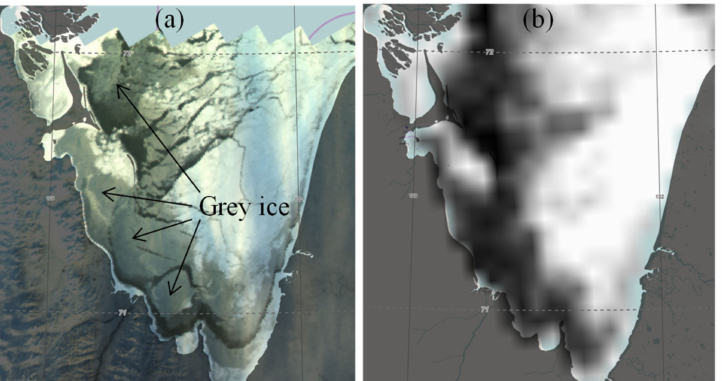
Figure 9. ( a ) MODIS optical image of the Bay of Buor-Khaya in the Laptev Sea on 1 November 2022, 02:55 UTC. ( b ) SIC daily averaged product, produced in the University of Bremen from the AMSR2 data with